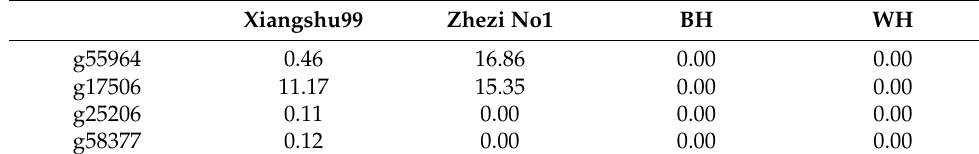
Table 5. The FPKM value of genes in varieties.